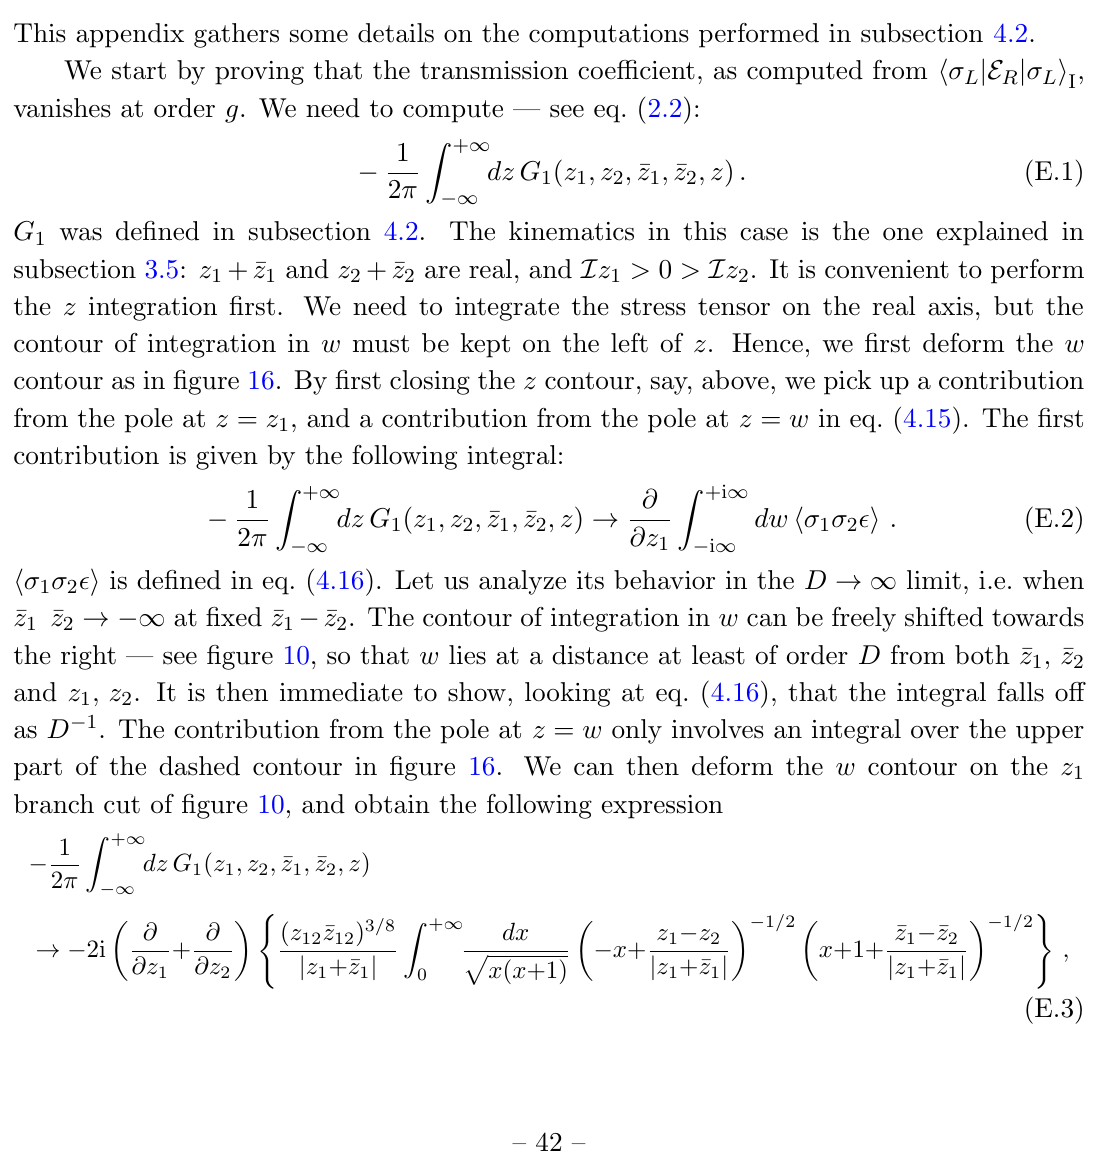
Figure 16 . Contours which de(cid:12)ne the expectation value h (cid:27) L jE R j (cid:27) L i zontal line is the contour of integration in z , while the dashed line is the contour of integration in w . The integrand, eq. (4.15) has poles in z at z = z 1 ; z 2 ; w . The position of z 1 and z 2 is compatible with the kinematics described in subsection